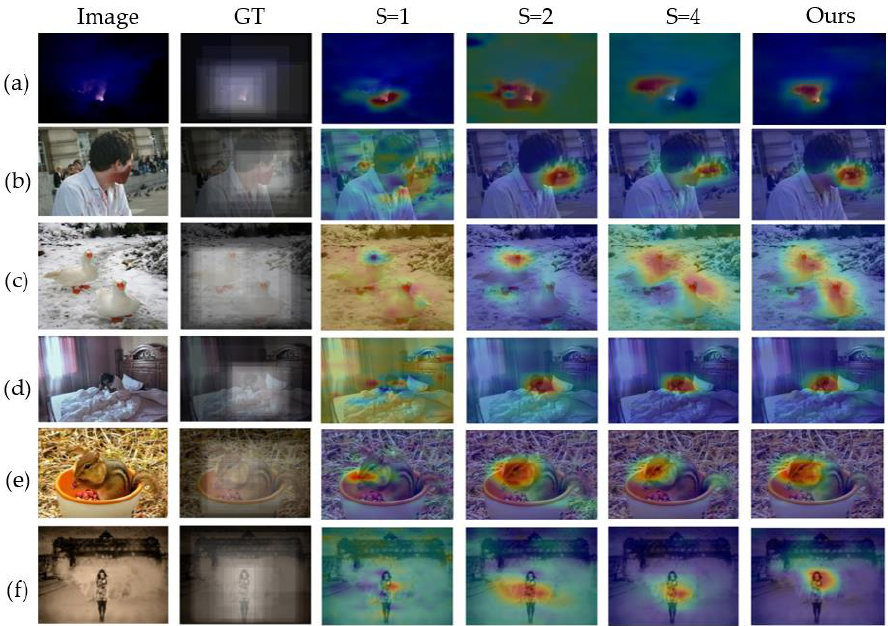
Figure 10. Visualization of the proposed model on EmotionROI. Here we compare with different scale of S = 1, S = 2, S = 4. Our method uses S = [1,2,4]. GT is the ground truth. As shown in ( b – d ), S = 2 and S = 1 are better than S = 4. However, in figure ( a ) the case of S = 1 is better than the case of S = 2 and S = 4. ( e , f ) reflect the different effects of different scales on the same object. These examples show that multi-scale models have more stable object perception capabilities than single-scale models.